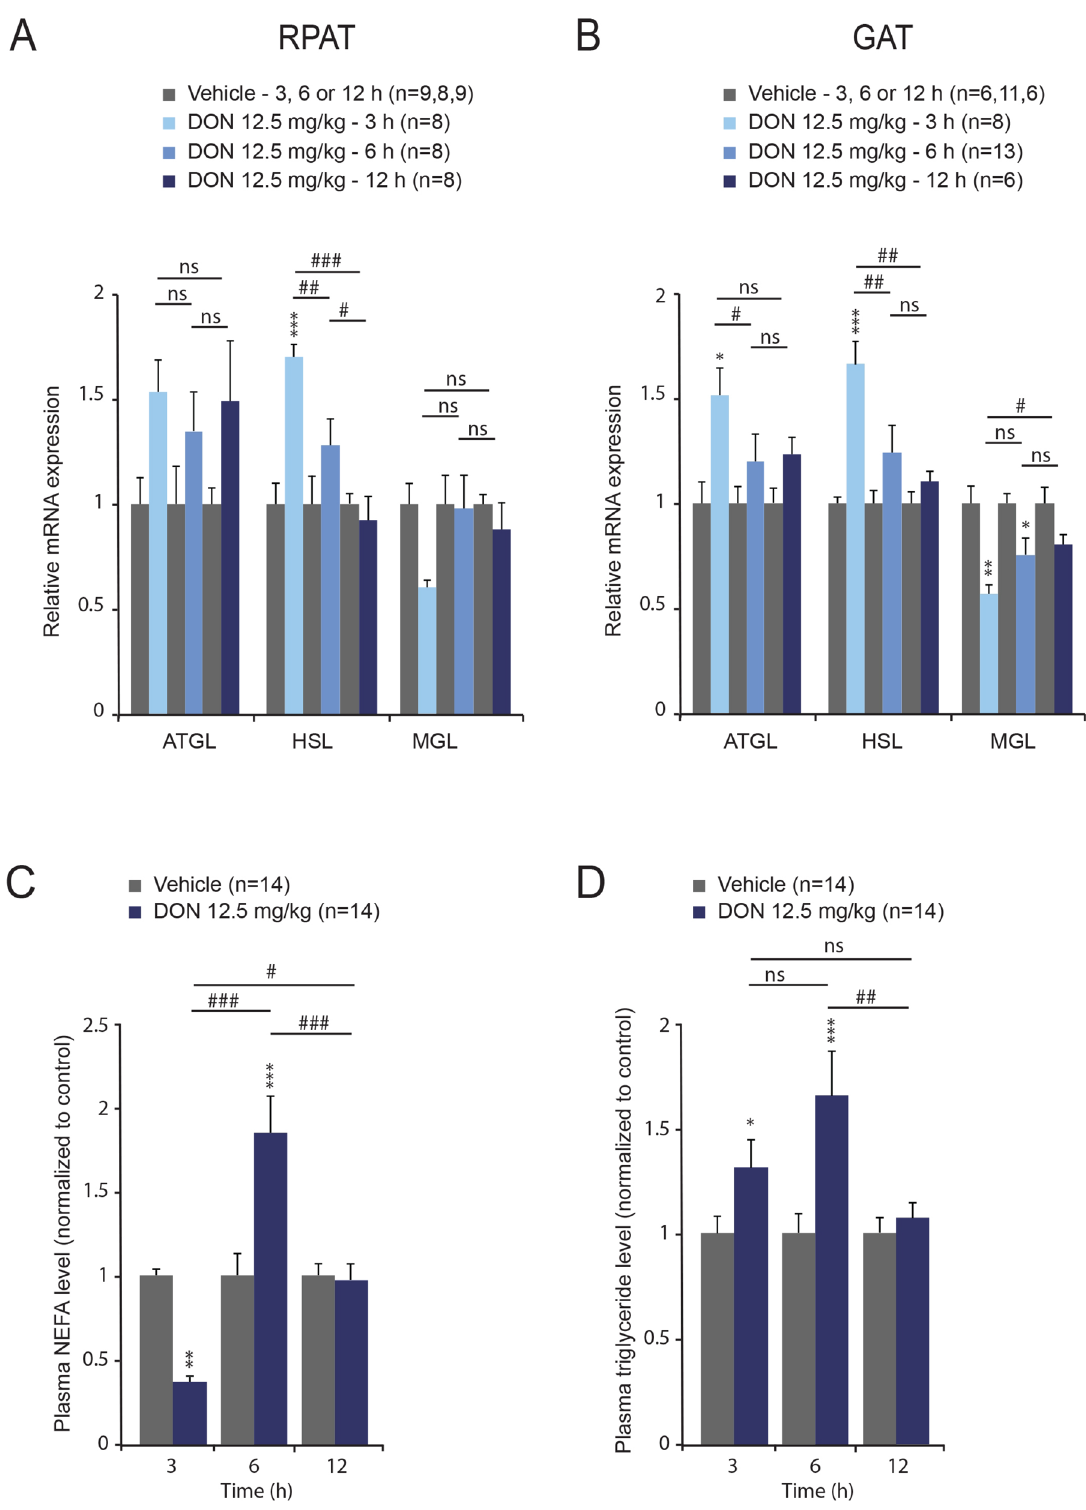
Figure 8. The expression of genes coding lipolytic enzymes was measured by qRT-PCR from RPAT ( A ) and GAT ( B ) of control and DON-challenged animals for the indicated times. Dosages of NEFAs ( C ) and TGs ( D ) concentrations assayed for vehicle- and DON-treated animals. A two-way analysis of variance test was performed between time series (3, 6 and 12 h) of DON-treated and untreated mice. * P < 0.05, ** P < 0.01 and *** P < 0.001 significantly different from control mice. # P < 0.05, ## P < 0.01 and ### P < 0.001 significant difference between time point of DON-treated mice. ns: no significant